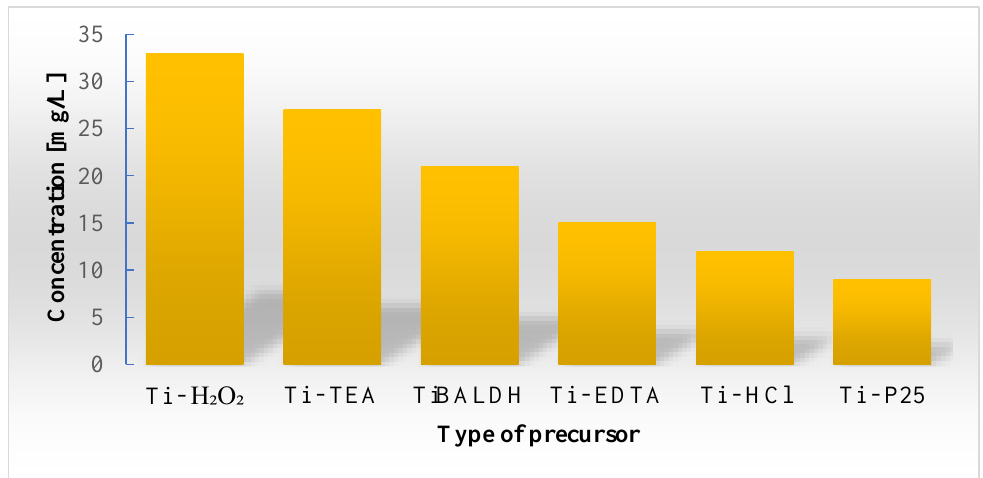
Figure 4. The limit of inhibition concentration depending on the type of titanium precursor used: Ti–H 2 O 2 : Ti–hydrogen peroxide; Ti–TEA: Ti–triethanolamine; TiBALDH: titanium(IV) bis(ammonium lactate)dihydroxide; Ti–EDTA: Ti–ethylenediaminetetraacetic acid; Ti–HCl: acid digested hydrolyzed titania; Ti–P25: titanium(IV) oxide.